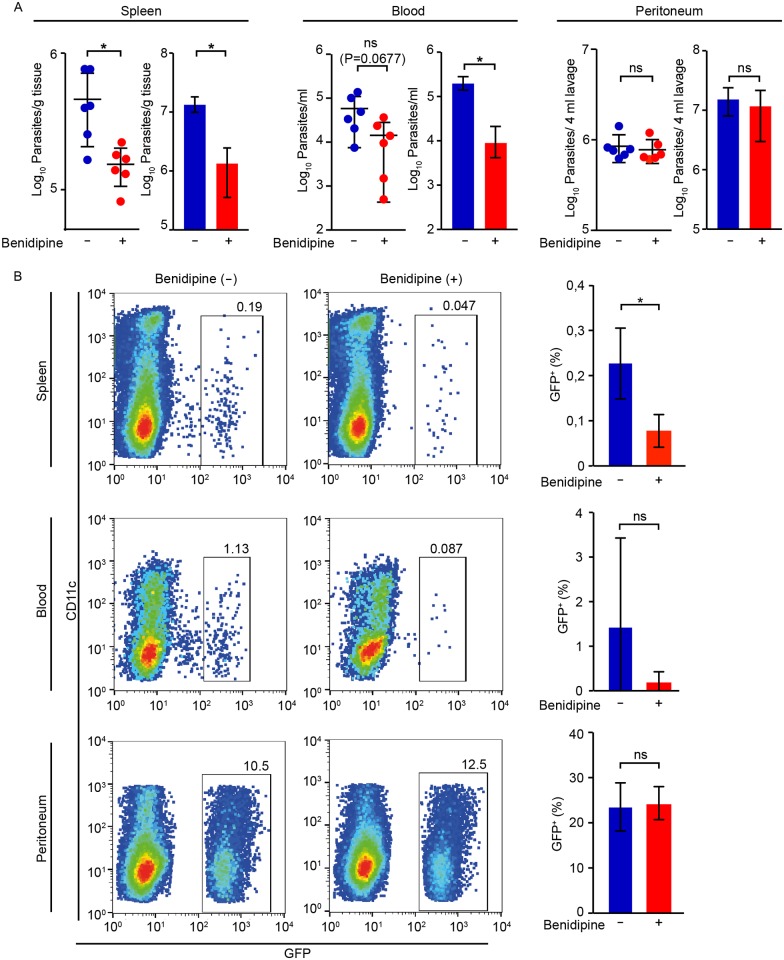
Impact of VDCC inhibition on parasite loads and cell-associated parasite numbers in spleen, blood and peritoneum 24 h post-inoculation in mice.(A) Parasite loads in spleen, blood and peritoneum, as indicated, 24 h post-inoculation of 5x106
T. gondii (PTGluc)-challenged DCs ± benidipine in C57BL/6 mice. For each tissue, dot plots show parasite numbers quantified by plaquing assays and bar graphs show parasite quantification by qPCR, as indicated under Material and Methods. Data represents mean ± SD from 3 independent experiments. (*: p < 0.05, ns: p ≥ 0.05, Student´s t-test, n = 6). (B) Flow cytometry analysis of spleen, blood and peritoneal fluid 24 h post-inoculation of 5x106
T. gondii (PTGluc, GFP-expressing)-challenged DCs ± benidipine, as indicated under Materials and Methods. Bivariate dot plots show, for each condition, GFP+ cells and CD11c+ cells, following gating on live CD3- CD19- GR1-NK1.1- CD11b+ cells. Gatings indicate percentage of GFP+ cells related to the total cell population. Bar graphs indicate, for each condition, the percentage of GFP+ cells from 3 independent experiments (*: p < 0.05, ns: p ≥ 0.05, Student´s t-test, n = 5–6).